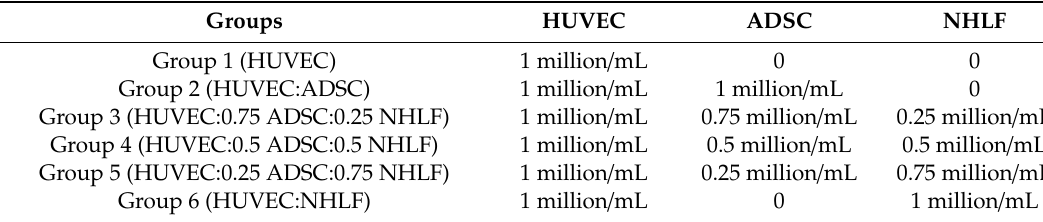
Table 1. Cell combinations for vessel formation.